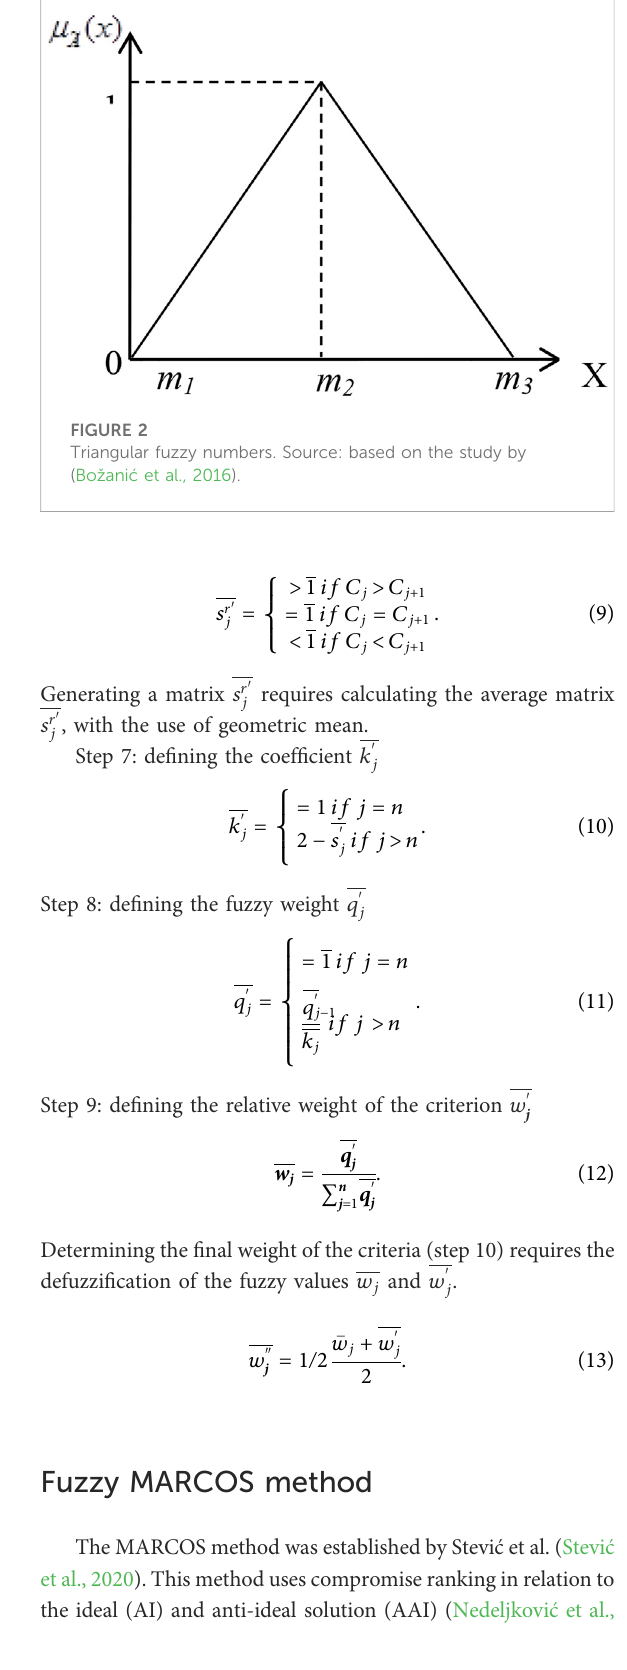
TABLE 3 Fuzzy number membership function.